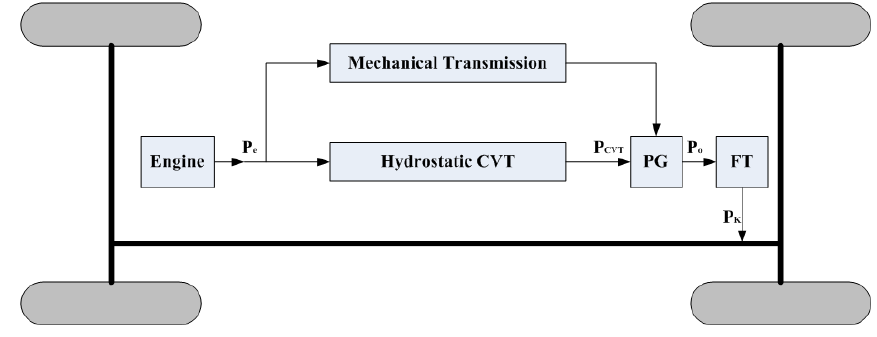
Figure 6. Mechanical transmission, backward power recirculation.